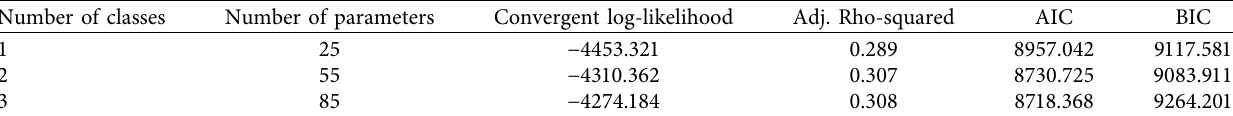
Table 2: Goodness of ft for the latent class